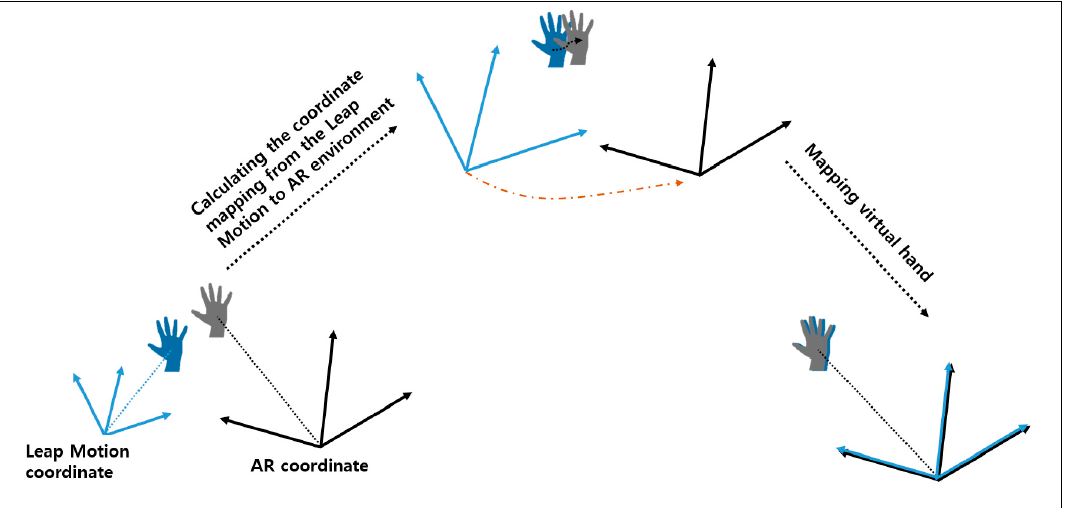
Figure 9. Calibration between the two coordinates.